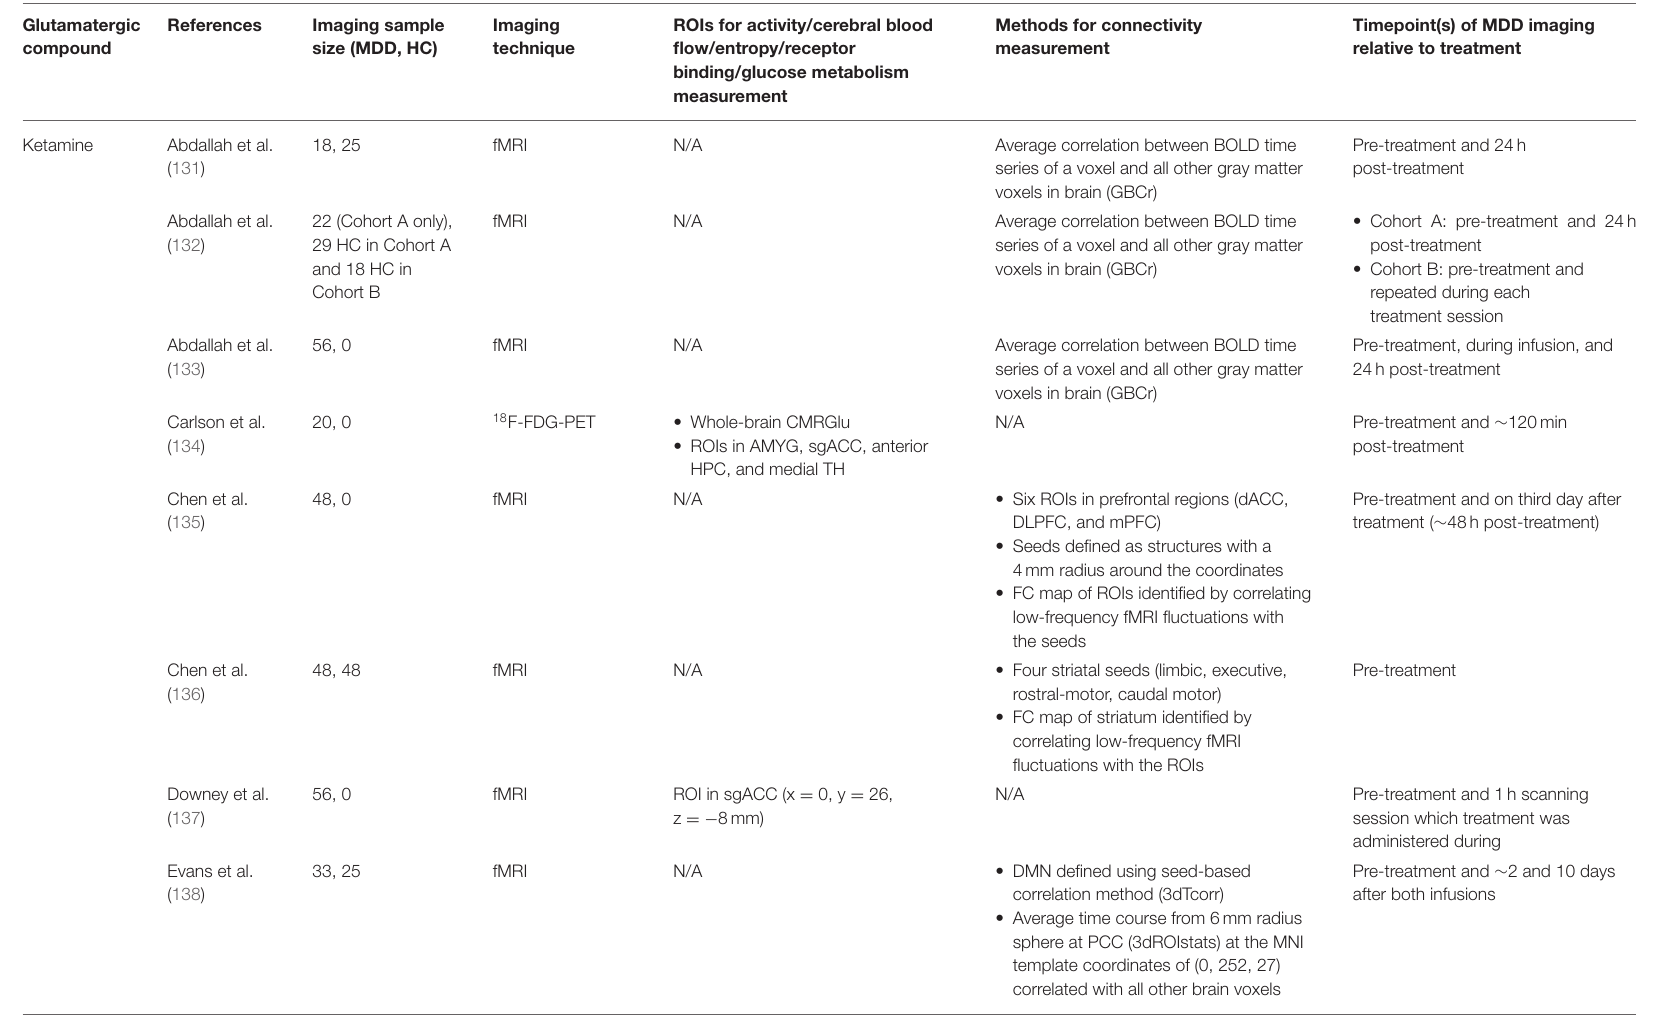
TABLE 3 | Neuroimaging methods of reviewed studies. Glutamatergic